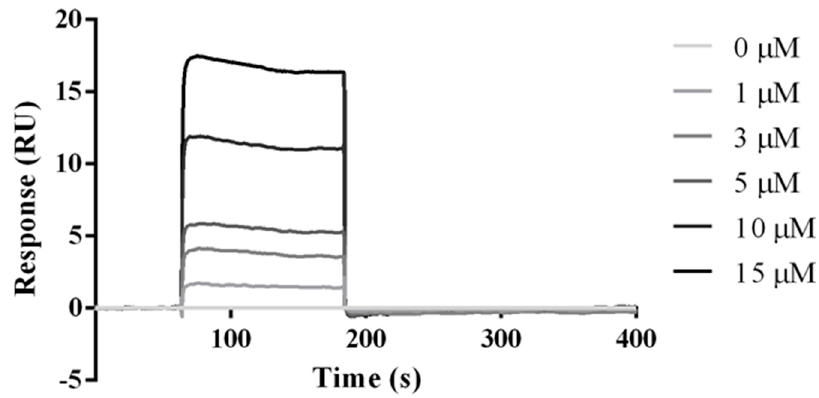
Figure 6. SPR analysis of the BTLA protein binding to the HVEM (14–39) peptide. Sensorgrams show the results of SPR analysis conducted on the binding of the indicated concentrations of BTLA protein (C = 0, 1, 3, 5, 10, and 15 µ M) in HBS-EP bu ff er. Constants were determined based on four measurements: k 1 = 7.64 × 10 4 1 / Ms ± 6.81 × 10 4 ; k − 1 = 3.32 × 10 − 3 1 / s ± 1.55 × 10 − 3 ; K D = 1.02 × 10 − 7 M ± 0.97 × 10 − 7 , where k 1 is the association rate constant, k − 1 is the dissociation rate constant, and K D = k 1 / k − 1 . Table 1. Rate constants: k 1 , k − 1 and K D for the BTLA / HVEM and BTLA / HVEM (14–39) complexes determined using SPR and molecular dynamics simulation. The comparison of K D BTLA / HVEM (No. 1) and K D BTLA / HVEM (14–39) (No. 2) = 2.45; K D BTLA / HVEM crystal-based structure (No. 3) and K D BTLA / HVEM (14–39) crystal-based structure (No. 4) = 5.88; K D BTLA / HVEM crystal-based structure (No. 3) and K D BTLA / HVEM (14–39) NMR-based structure (No. 5) = 6.51; K D BTLA / HVEM (14–39) crystal-based structure (No. 4) and K D BTLA / HVEM (14–39) NMR-based structure (No. 5) =